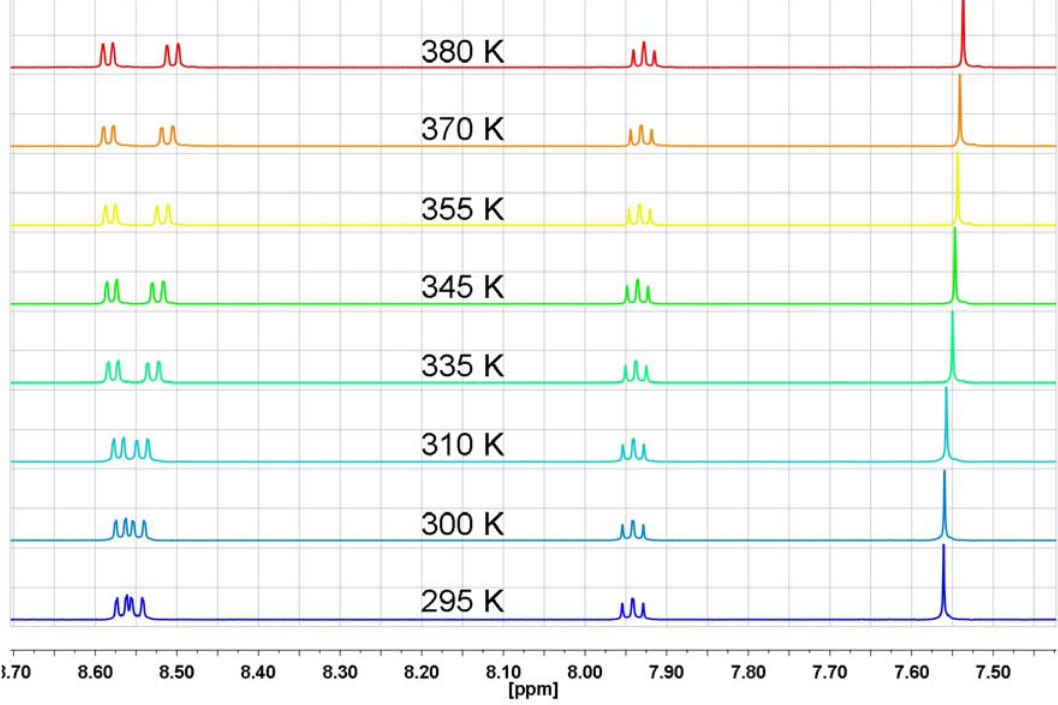
Figure 10. The range of aromatic protons of 1 H-NMR spectrum in DMSO-d N,N ′ -(1,4-phenylene)-bis(1,8-naphthalimide) ( NP2 ) at different